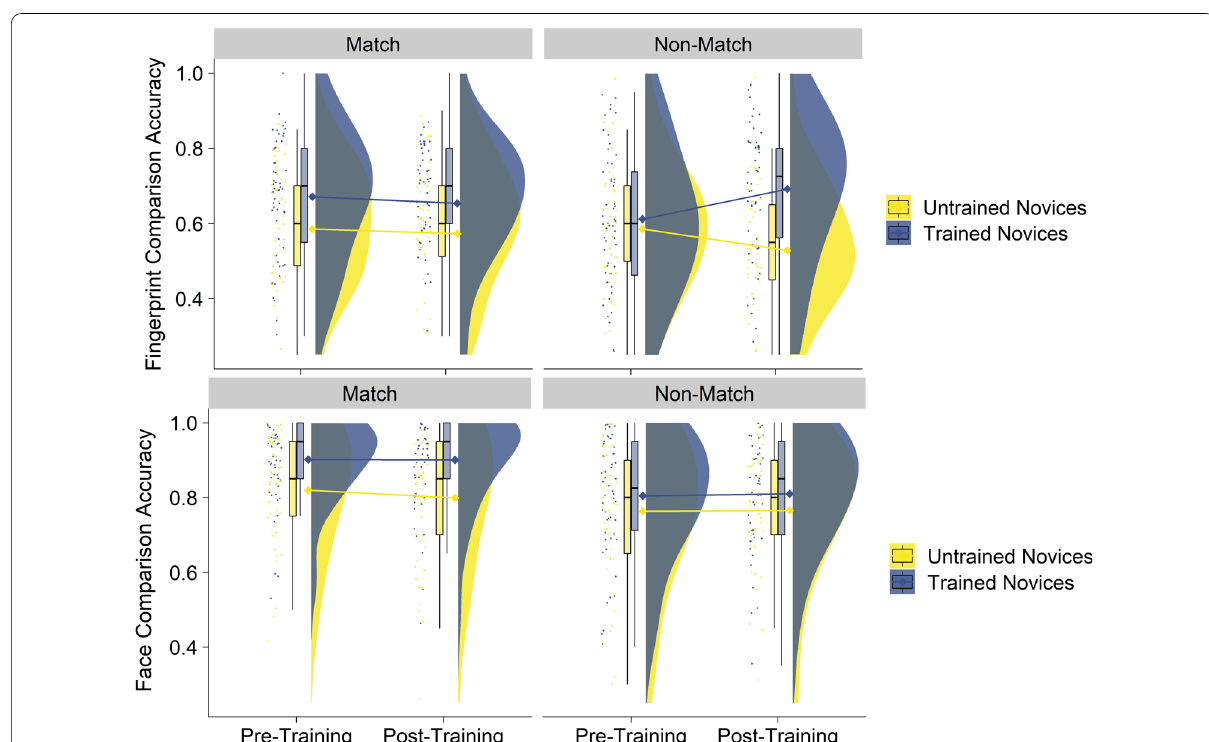
Fig. 10 Fingerprint (upper panel) and face (lower panel) match and non-match accuracy pre-to-post-training between untrained and trained novices in Experiment 1